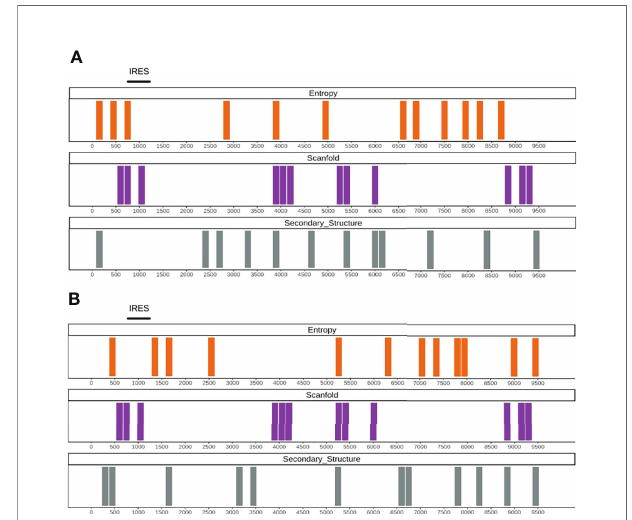
FIGURE 3 | (A) Output example of the RNAvigator pipeline for the complete HCV genome showing the bottom 20% regions for SHAPE reactivity (Secondary_Structure; gray), Scanfold z-score (Scanfold; purple), and the entropy obtained by using SHAPE data as input inside Superfold (Entropy; orange). The notorious functional element IRES is highlighted at the top. (B) Output example of the RNAvigator pipeline for the complete HCV genome showing the bottom 20% regions for CROSS predictions (Secondary_Structure; gray), Scanfold z-score (Scanfold; purple), and the entropy obtained by using CROSS SHAPE-like data as input inside Superfold (Entropy; orange). The notorious functional element IRES is highlighted at the